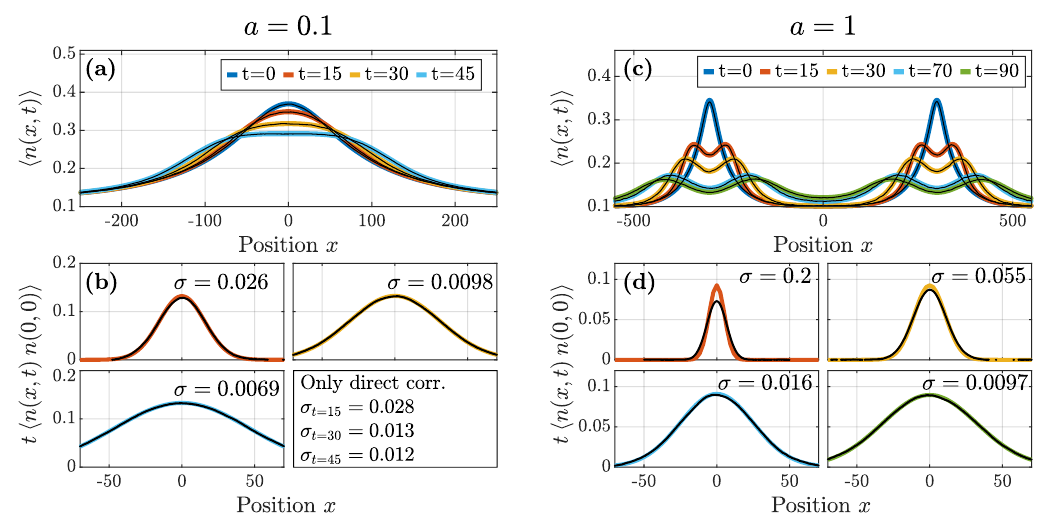
Figure 2: Bump releases in the classical hard-rod model for two different rod lengths a = 0.1 ( a = 1). Results were calculated using GHD (colored lines) and Monte- Carlo methods (black lines). Parameters of the Monte-Carlo simulations are specified in the main text. (a,c) Comparison of the evolution of the linear density. (b,d) Comparison of the two-point correlation function t 〈 n ( x , t ) n ( 0,0 ) 〉 along with